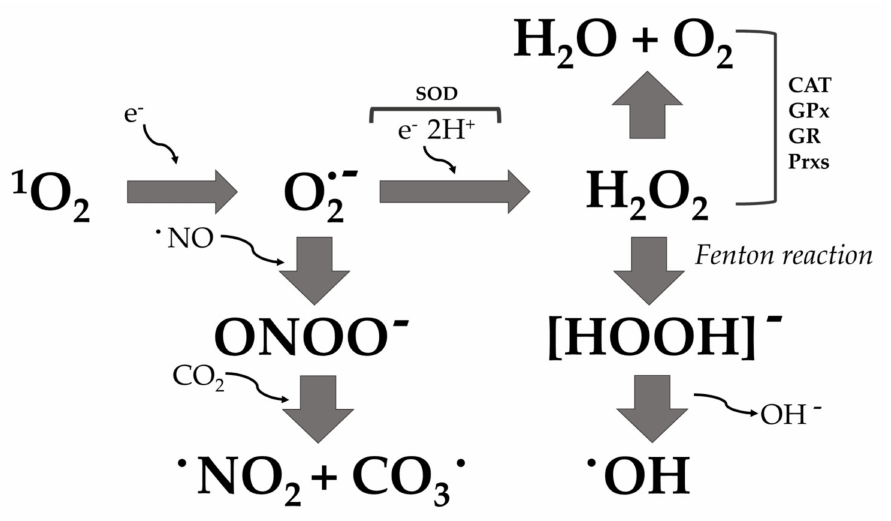
Figure 2. ROS production pathways: 1 O 2 , singlet oxygen; O 2 · − , superoxide anion; · OH, hydroxyl radical; ONOO − , peroxynitrite anion; · NO 2 , nitrogen dioxide radical; CO 3 · , carbon trioxide. SOD, superoxide dismutase; CAT, catalase; GPx, glutathione peroxidase; GR, glutathione reductase; Prxs,